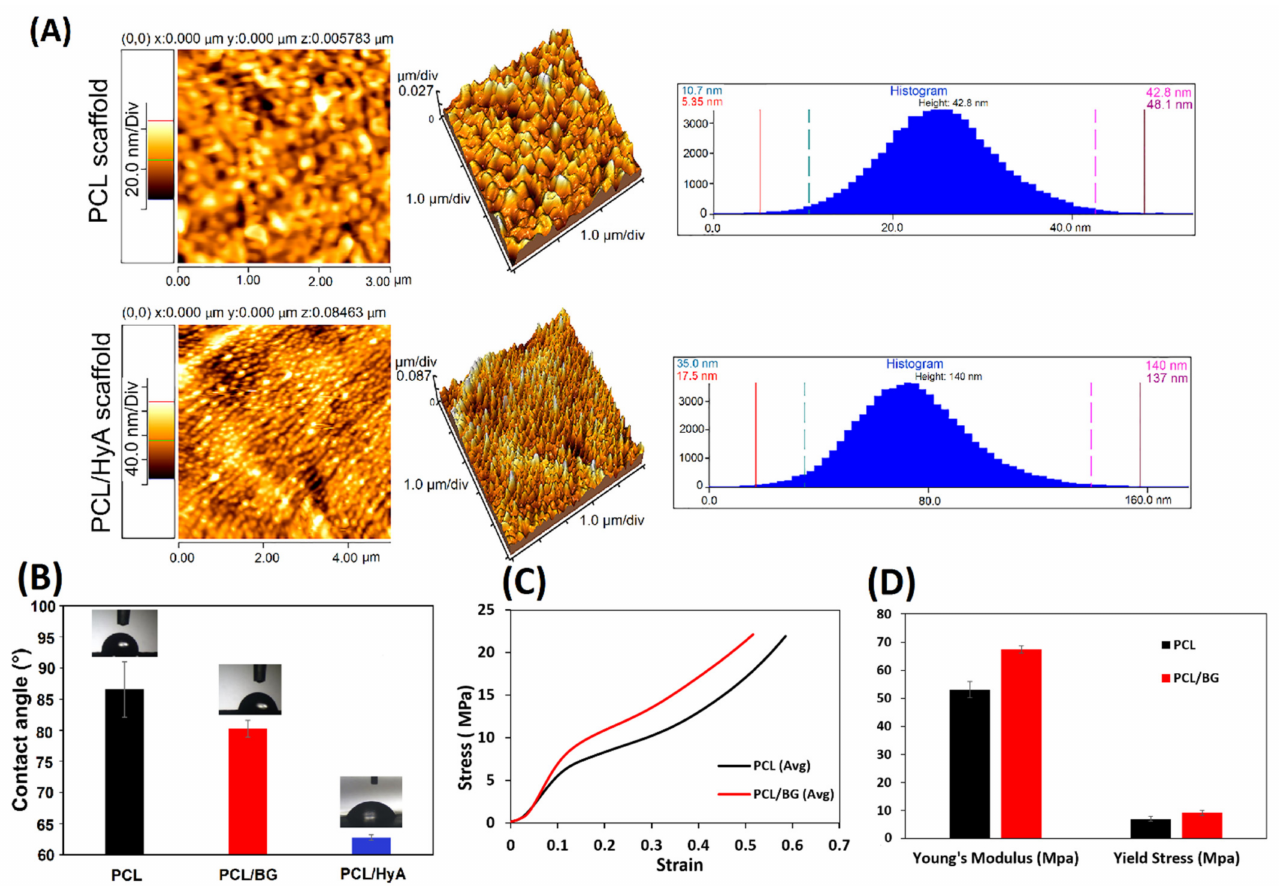
Figure 4. ( A ) Surface topography of 3D-printed PCL scaffolds with differential morphologies PCL and PCL/HyA obtained with AFM analysis; ( B ) contact angle measurement of 3D-printed PCL, PCL/BG, and PCL/HyA scaffolds; ( C ) compressive stress versus strain responses of PCL and PCL/BG 3D-printed scaffolds; ( D ) Young’s modulus and yield strength values of PCL and PCL/BG 3D-printed